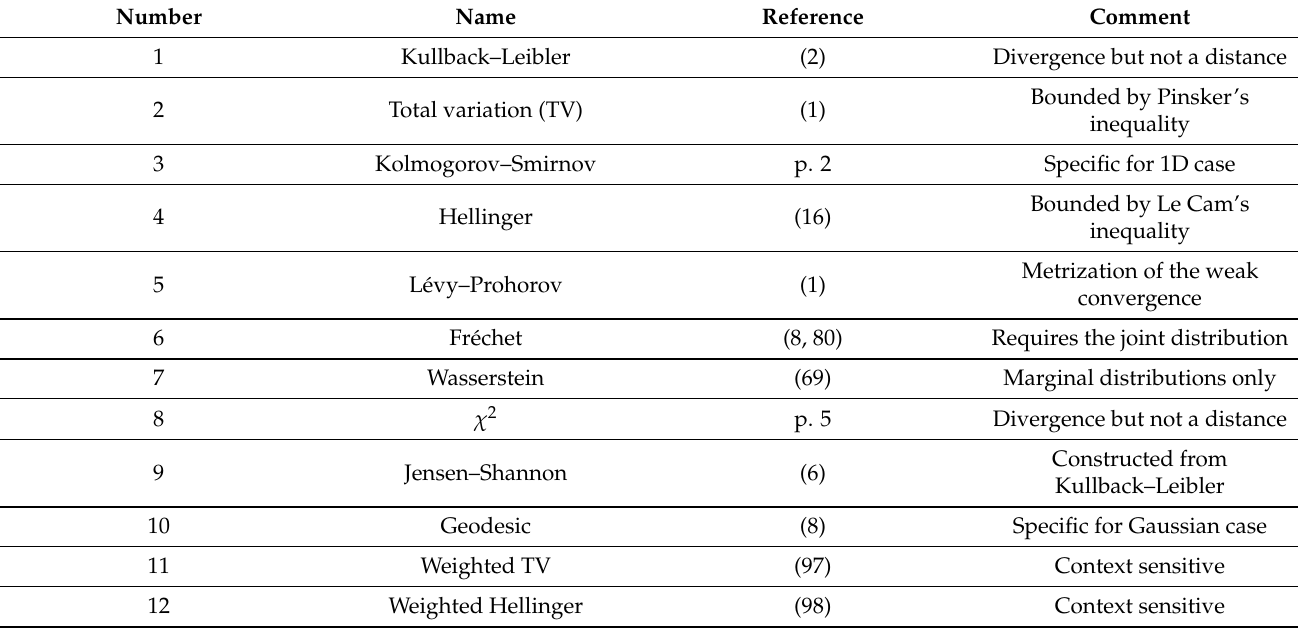
Table 1. The main metrics and